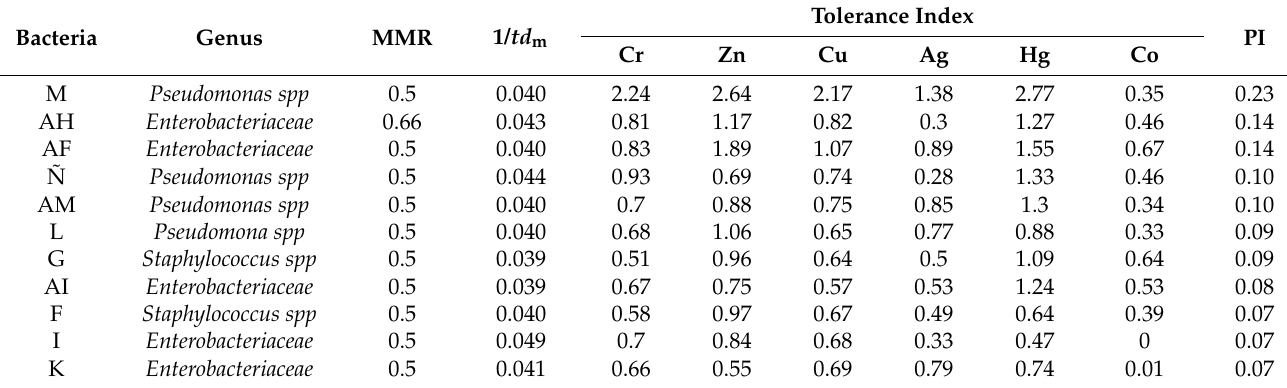
Table 6. Candidate bacteria for future adsorption systems for heavy metals